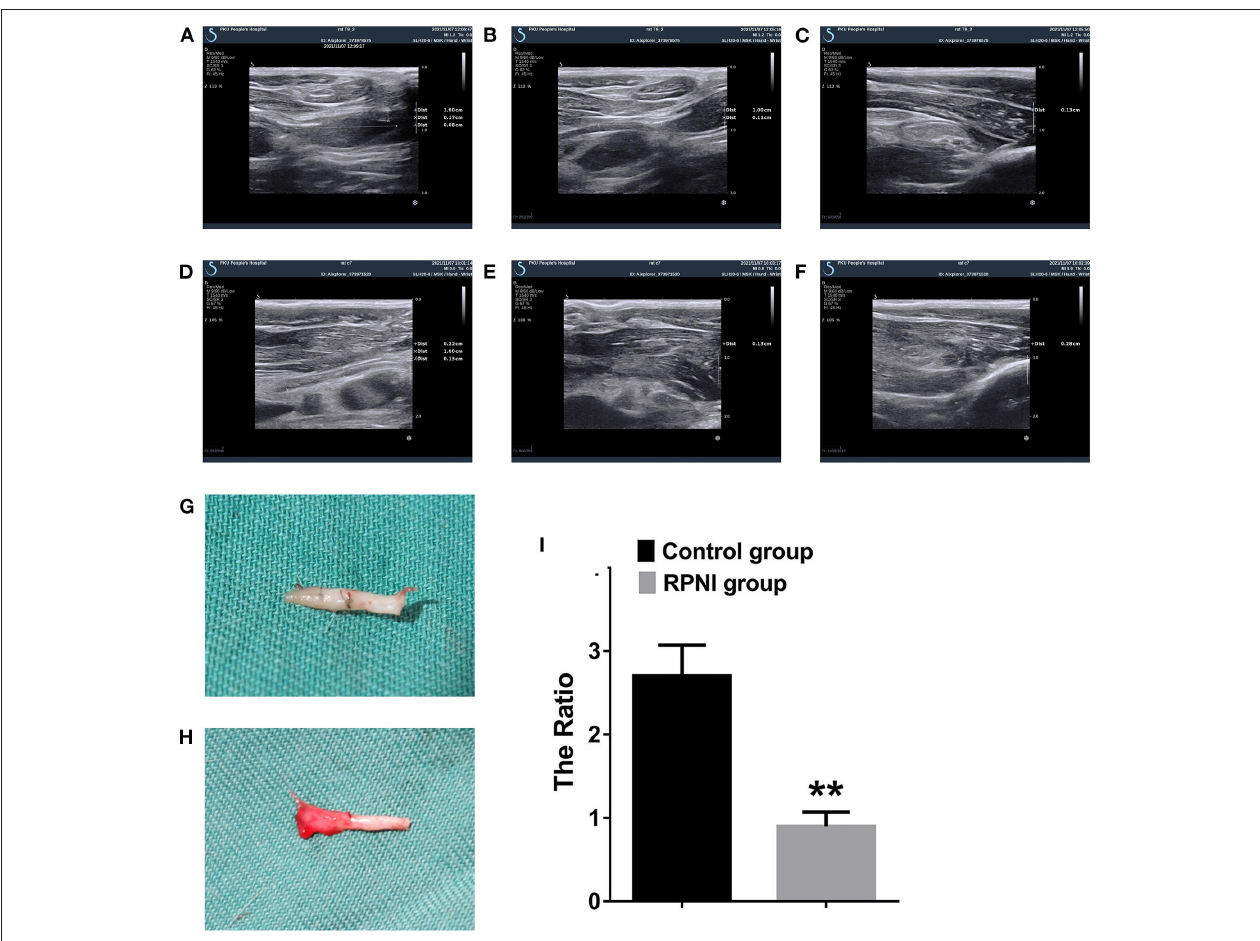
FIGURE 3 | Ultrasound images of rat nerve endings at 8 weeks postoperation. (A) Longitudinal section of RPNI rat along the course of the nerve ( + indicates the muscle used to wrap the nerve in the establishment of RPNI, × indicates the distal end of the nerve ending, which is the severed end, indicates the proximal end of the nerve, i.e., relatively normal nerve tissue). It is observed that the regeneration of nerve stumps in RPNI rats was insignificant, and there was no obvious nerve enlargement. (B) Proximal nerve ending in a RPNI rat. (C) Distal nerve ending of a RPNI rat. (D) The longitudinal section of a control group rat along the course of the nerve, without muscle wrapping, and showed that the nerve was significantly thickened. (E) Proximal nerve ending of a rat from the control group. (F) Distal nerve ending of a rat from the control group. (G) The morphology of the nerve of the RPNI group. There was no obvious expanded neuroma at the end of the nerve. (H) The morphology of the nerve of the control group. Expanded neuroma can be observed at the end of the nerve. (I) The ratio of the cross-sectional size of the nerve stump to the normal nerve tissue at the proximal end of the nerve endings is estimated by the product of the long diameter and the short diameter of the cross section. There are significant differences between the control group and the RPNI group (** P <